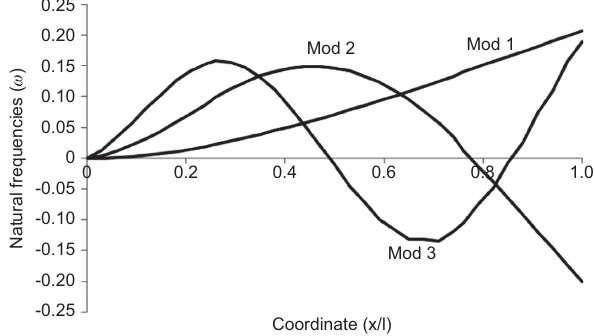
Figure 6 The first three mode shapes of symmetric (45 ° /-45 ° ) composite beam for the CF boundary condition.